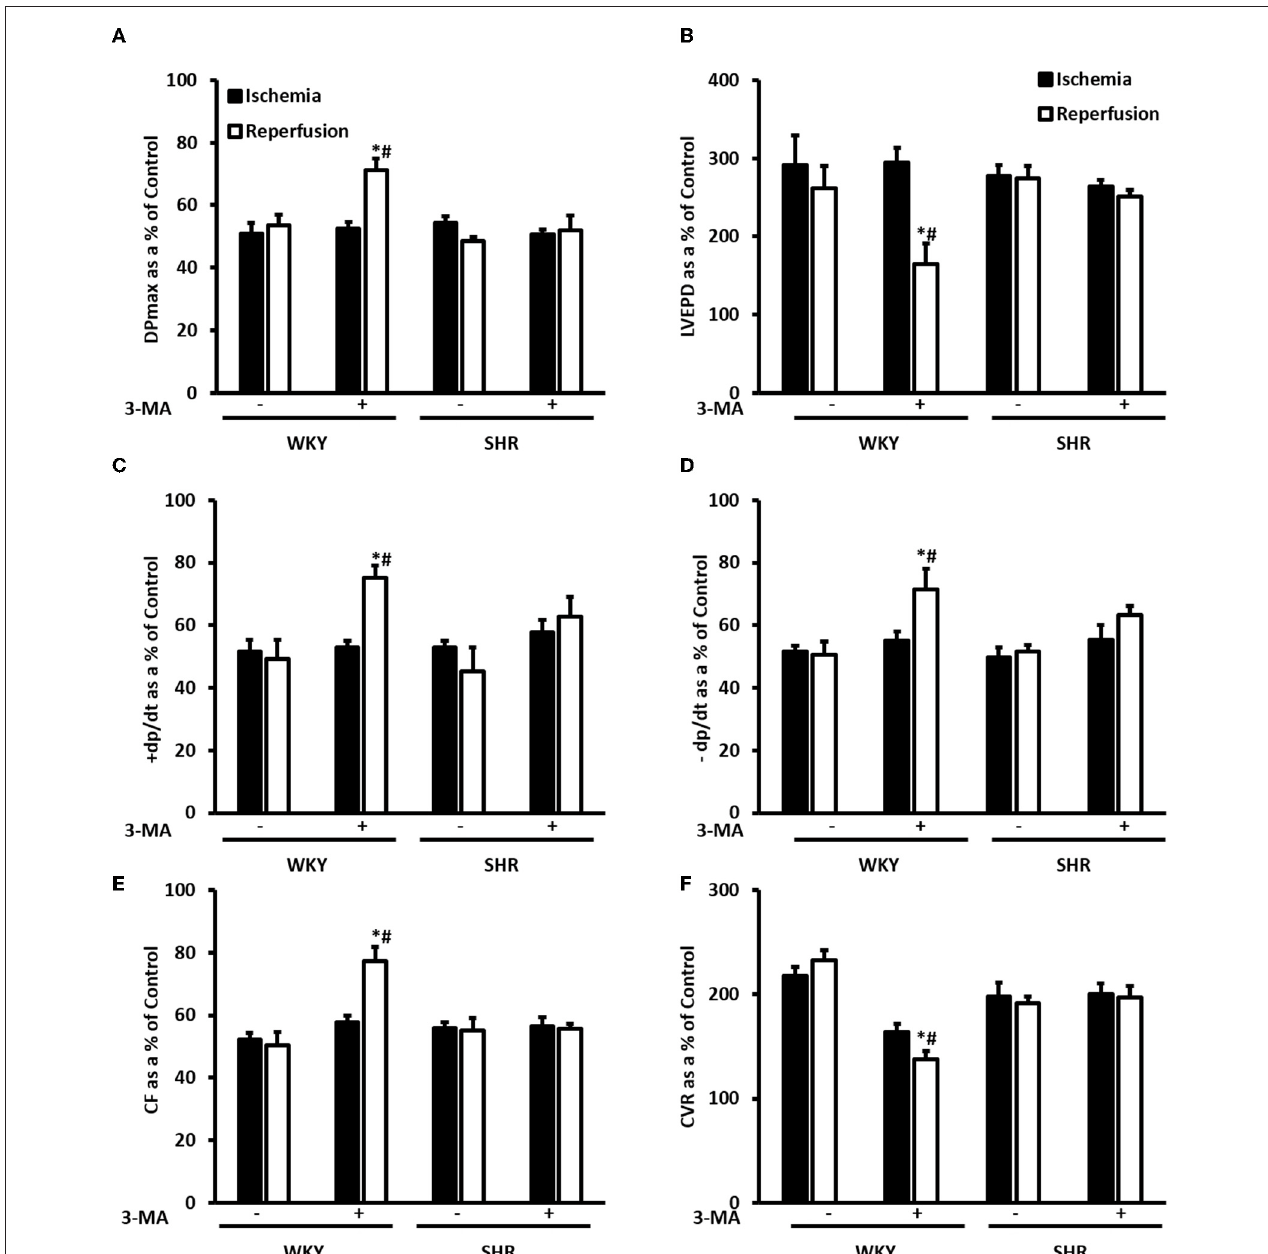
FIGURE 7 | Treatment with 3-MA protects WKY but not SHR against I/R injury. Post-ischemic recovery parameters of cardiac functions including DPmax (A) , LVEDP (B) , coronary hemodynamics (C,D) , cardiac contractility (E,F) . Data were computed with no addition control, with 3-MA (30 mg/Kg) administered into the femoral vein 2h prior to sacrifice. Data are expressed as means ± SEM. DPmax, maximum developed pressure; LVEDP, left ventricular end diastolic pressure; CF, coronary flow; CVR, coronary vascular resistance; 3-MA, 3-methyladenine; * P < 0.5 compared to ischemic period. # P < 0.5 compared to no addition control, n =